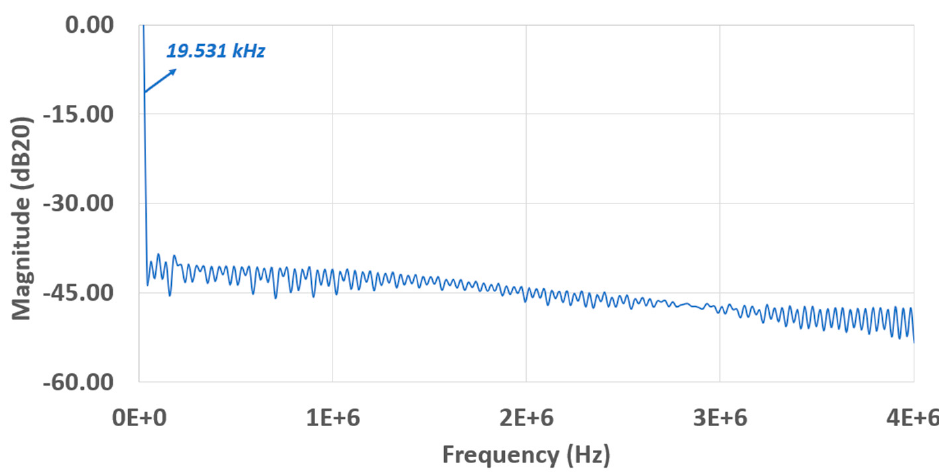
Figure 18. FFT spectrum with a 19.531 kHz input and a 20 MHz clock.